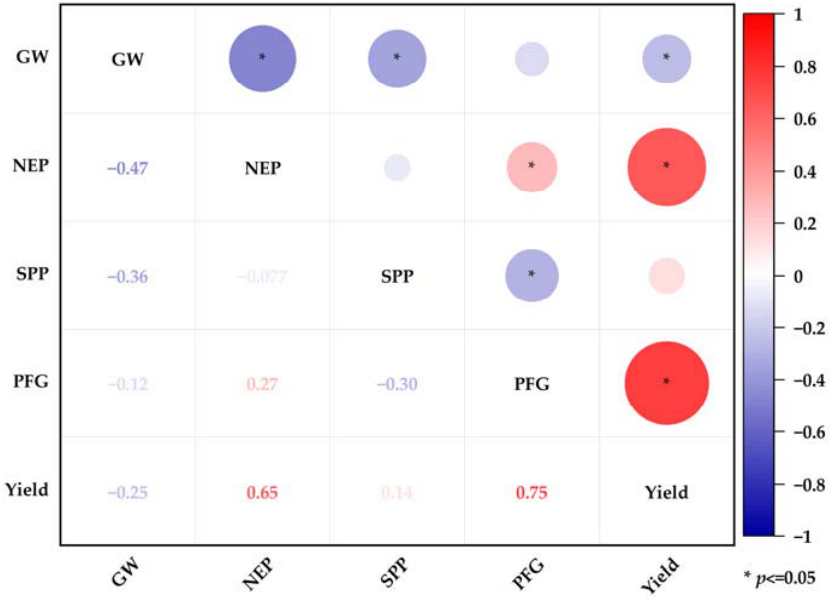
Figure 1. Heatmap of correlations between yield and yield components. Note: GW: 1000- grain weight; NEP: number of effective panicles; SPP: spikelets per panicle; PFG: percent- age of filled grains;* indicates significance at 0.05.